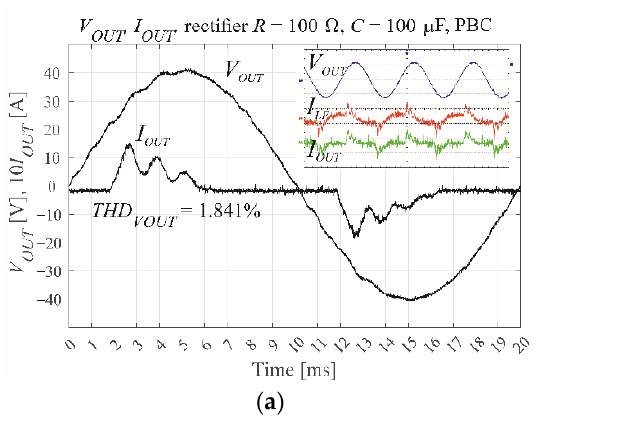
Figure 13. The PBC-controlled VSI output voltage and current as measured in-system using MicroLabBox for a nonlinear rectifier RC load with ( a ) R = 100 Ω, C = 100 μF, and M = 0.6, and ( b ) R = 100 Ω, C = 430 μF, and M = 0.6.